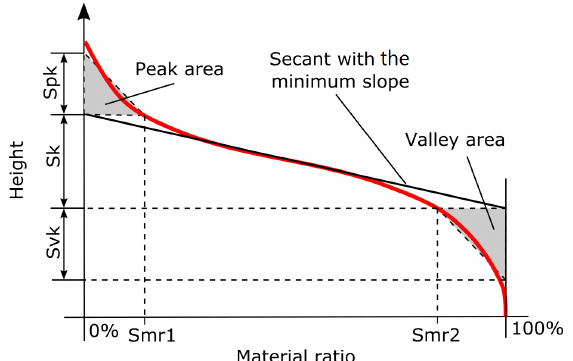
Figure 5. Graphical interpretation of the parameter Spk [36].